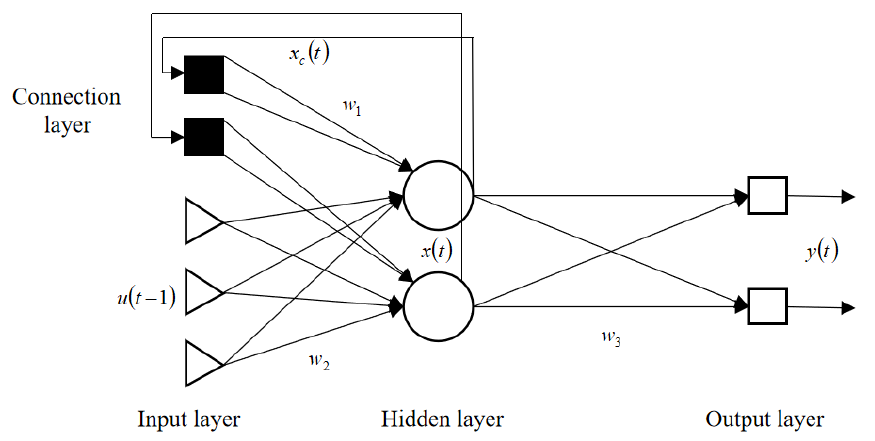
Figure 10. Elman neural network